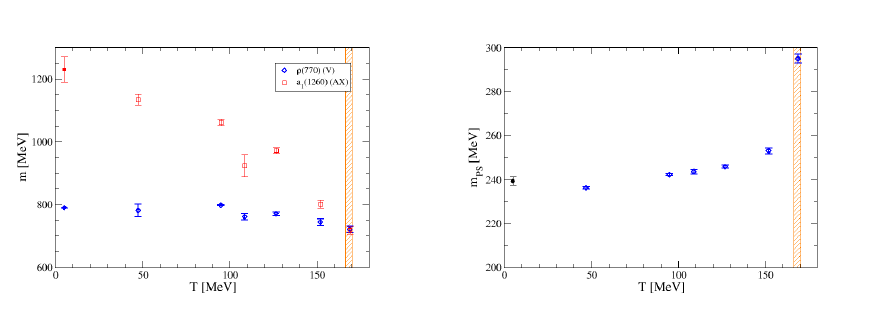
Figure 1. Light meson masses as function of temperature, from analysis of smeared correlators. Left: vector and axial-vector mesons, ρ and a 1 . Right: pion. The vertical band indicates the chiral crossover. The solid point for the ρ at T ≈ 0 represent the mass determined by the Hadron Spectrum collaboration on the same ensemble in a coupled-channel calculation using distillation and a variational analysis [16, 17], while that for a 1 is the Particle Data Group value for the